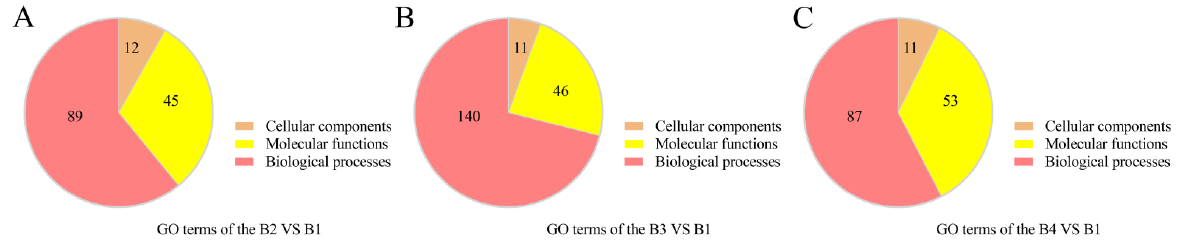
Figure 5. Overview of GO terms associated with the DEGs of the different comparisons. ( A ) GO terms enriched in the B2 vs. B1 comparison. ( B ) GO terms enriched in the B3 vs. B1 comparison. ( C ) GO terms enriched in the B4 vs. B1 comparison.